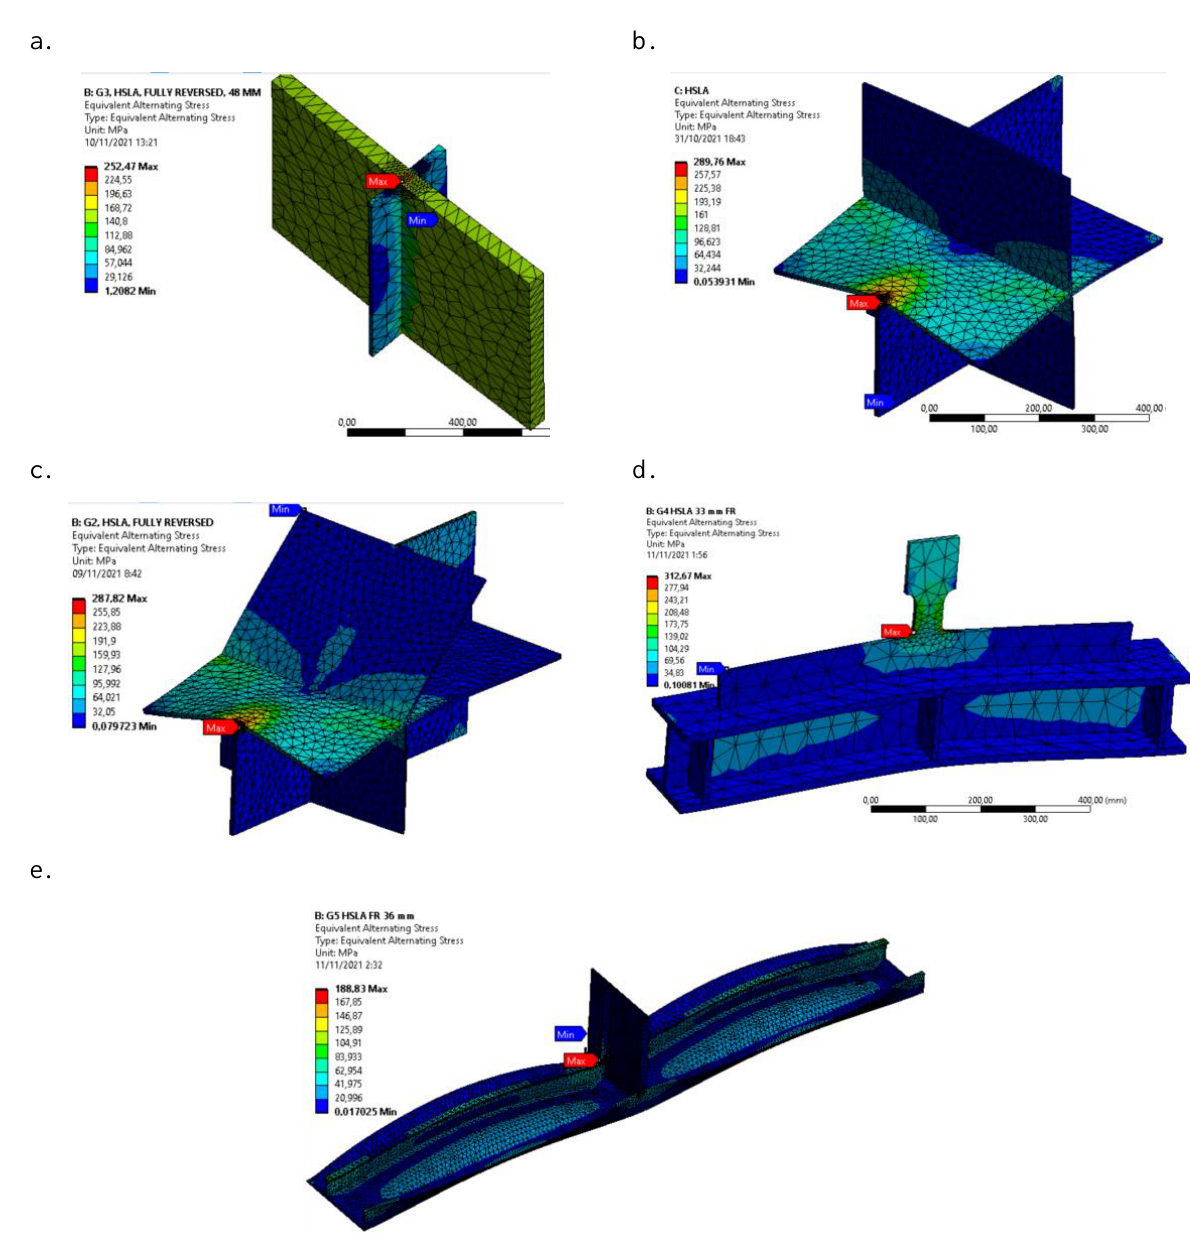
Figure 12. Alternating Stress Results: a. Geometry 1: Hatch Coaming Model [16]; b. Geometry 2: Perpendicular Figure 12: Alternating stress results: a. Geometry 1: Hatch coaming model [16]; b. Geometry 2: Perpendicular joint [12]; c. Geometry 3: Stool Joint [12]; c. Geometry 3: Stool Joint [12]; d. Geometry 4: Bottom-Stiffened Panel [27]; e. Geometry 5: Side- joint [12]; d. Geometry 4: Bottom-stiffened panel [28]; e. Geometry 5: Side-stiffened panel